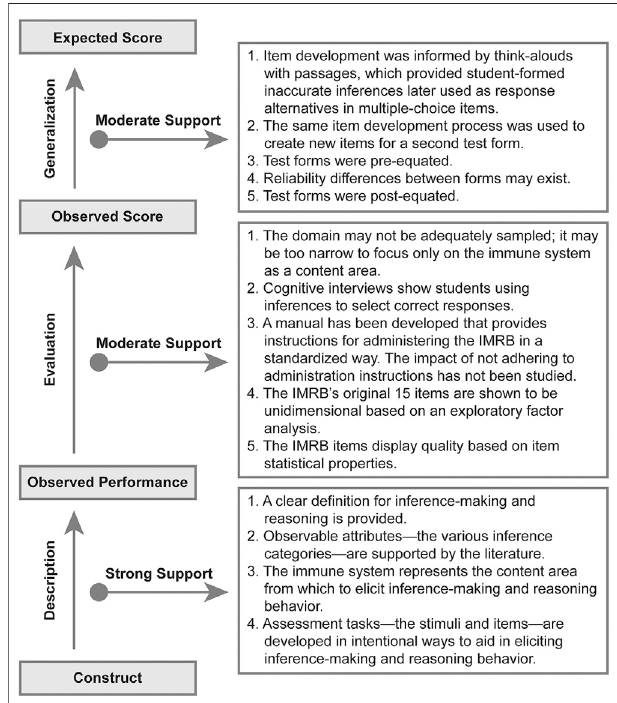
FIGURE 2 | (B). Summary of the IMRB validation research fi